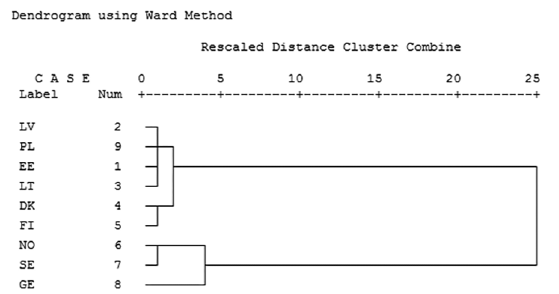
Fig. 8. Dendrogram representing the formation of countries’ clusters based on their maritime transport flows during 2010–2011